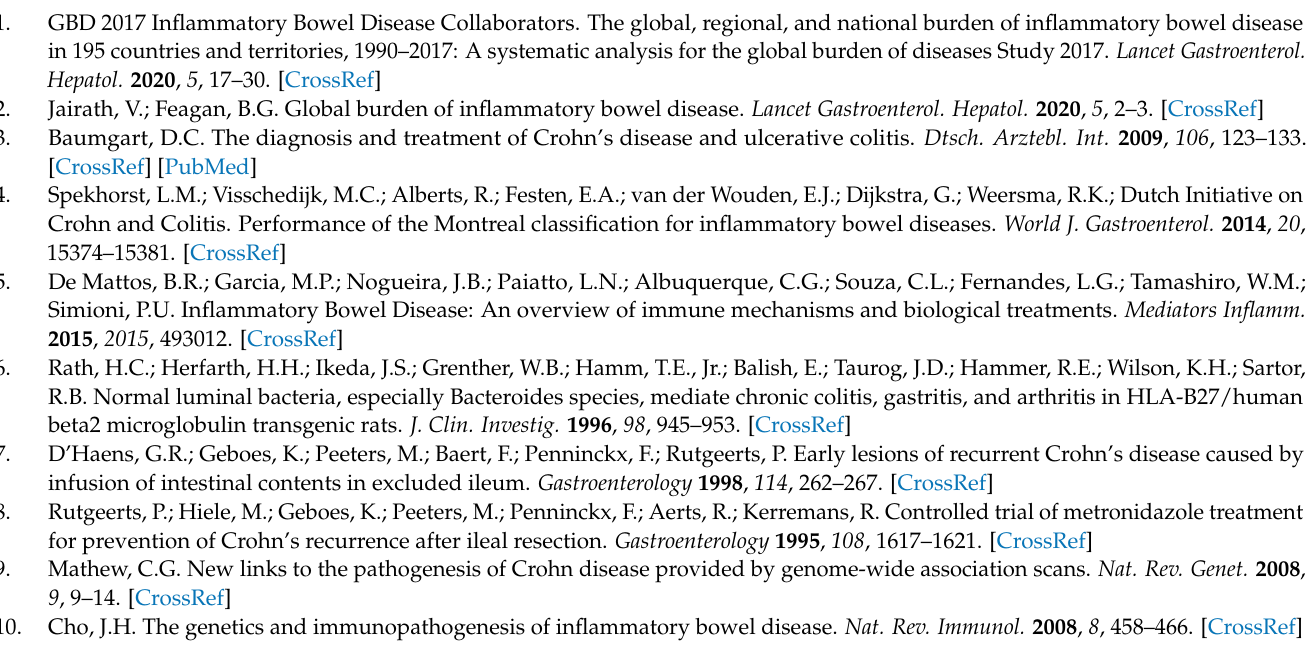
Table S2: Statistical report for Figure 3; Table S3: Selection of remarkable human proteins identified at the surface of the gut microbiome; Table S4: List of proteins over- or underrepresented in all clinical samples (all IBD, all CDIC, all CDC or all UC) compared to all controls; Table S5: List of proteins over- or underrepresented in all CDIC samples compared to all CDC, UC, and control samples; Table S6: List of proteins overrepresented in all CDC samples compared to all UC